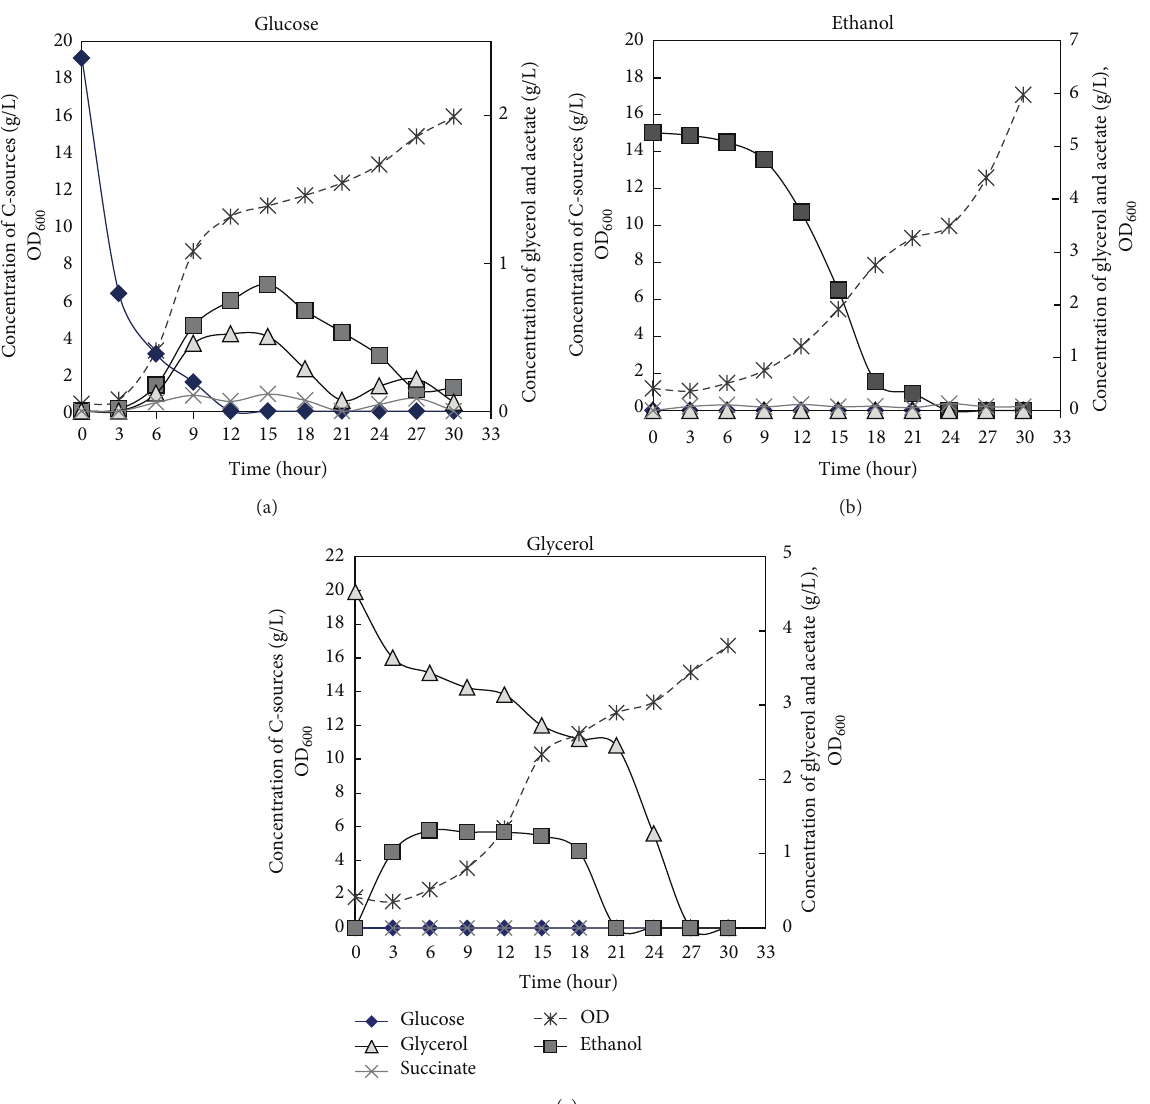
Figure 3: Profiles of growth (OD 600 ) and metabolite concentrations; glucose, glycerol, succinate, and ethanol of yeast BY4709 during the fermentationmeasured by HPLC. The plots show fermentation profile grown in different carbon sources; glucose (a), ethanol (b), and glycerol